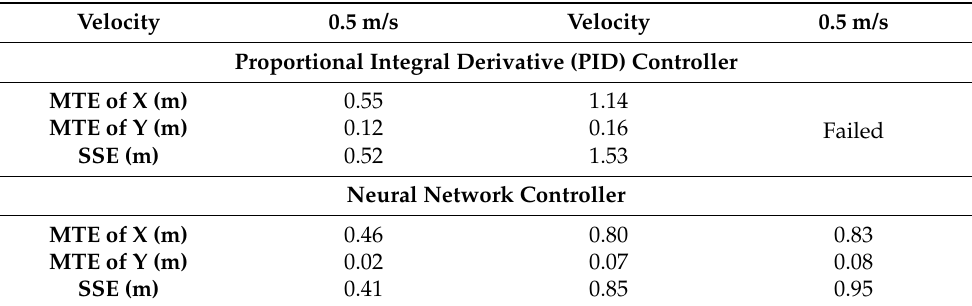
Table 2. Tracking error of UAV for tracking a line-moving target with different